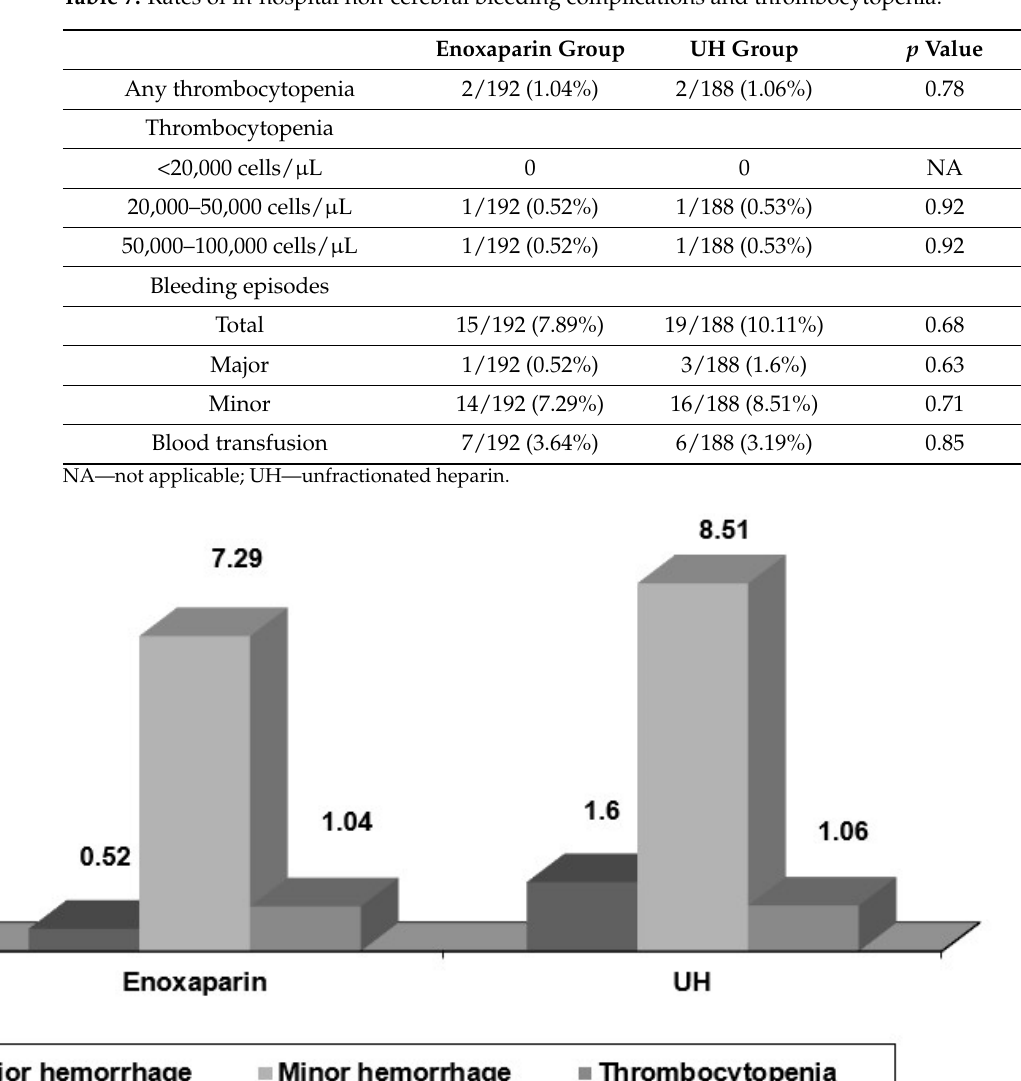
Table 7. Rates of in-hospital non-cerebral bleeding complications and thrombocytopenia.